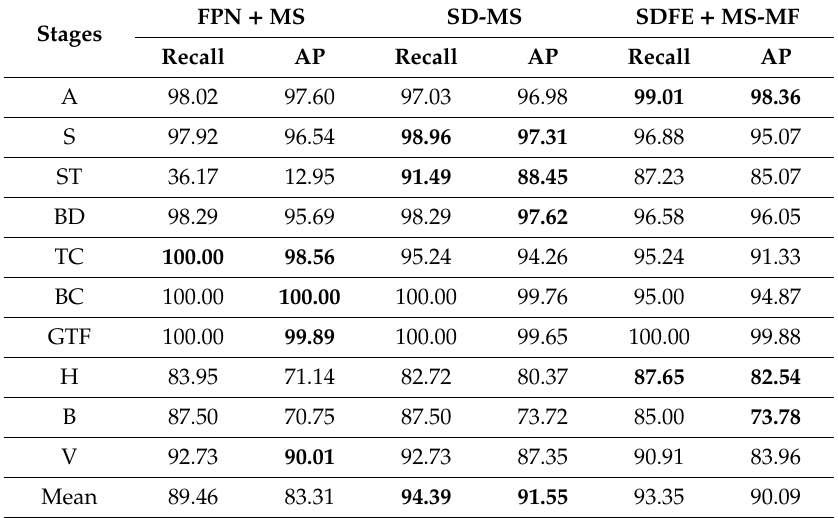
Table 3. The results of three experiments on the ten classes of the NWPU VHR-10 dataset.